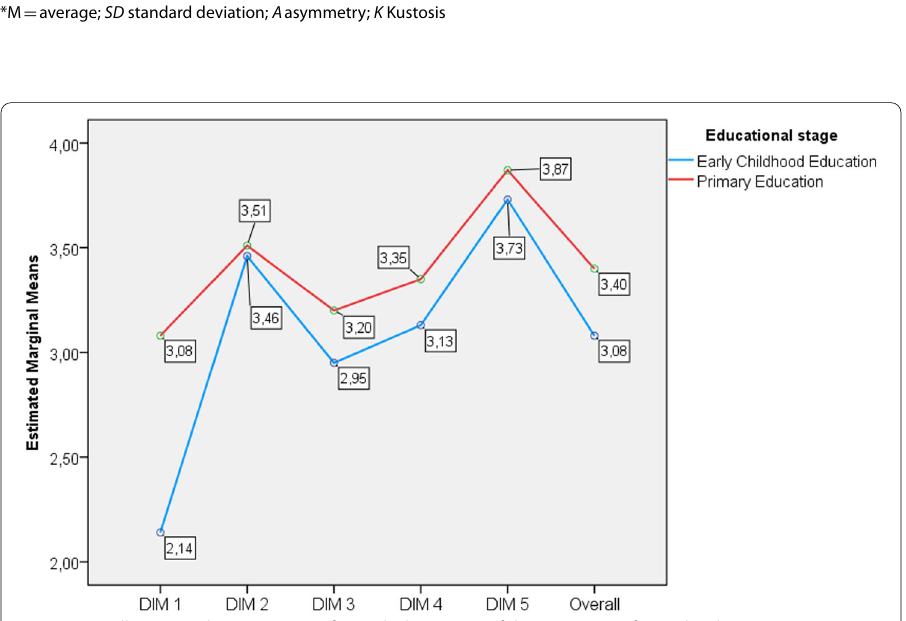
Fig. 1 Overall score and average score for each dimension of the instrument for each education